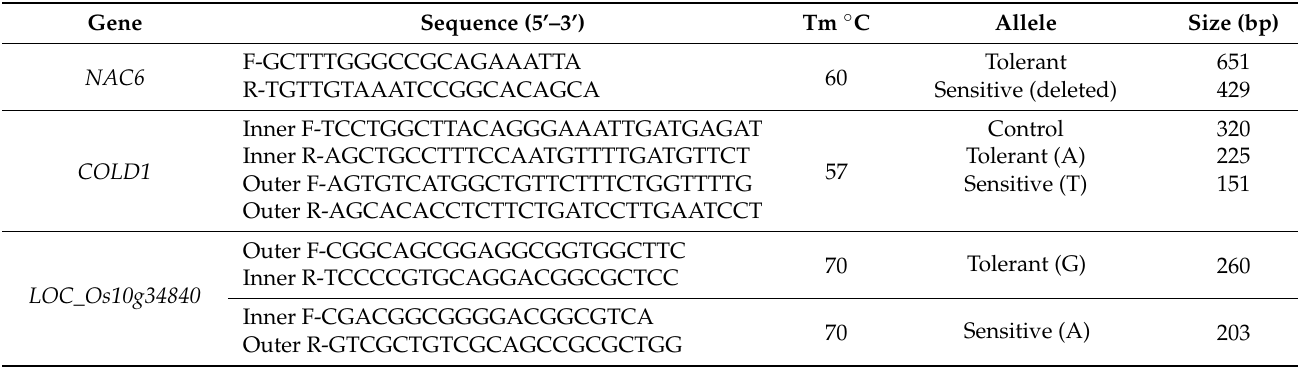
Table 1. Gene-specific primers used in this